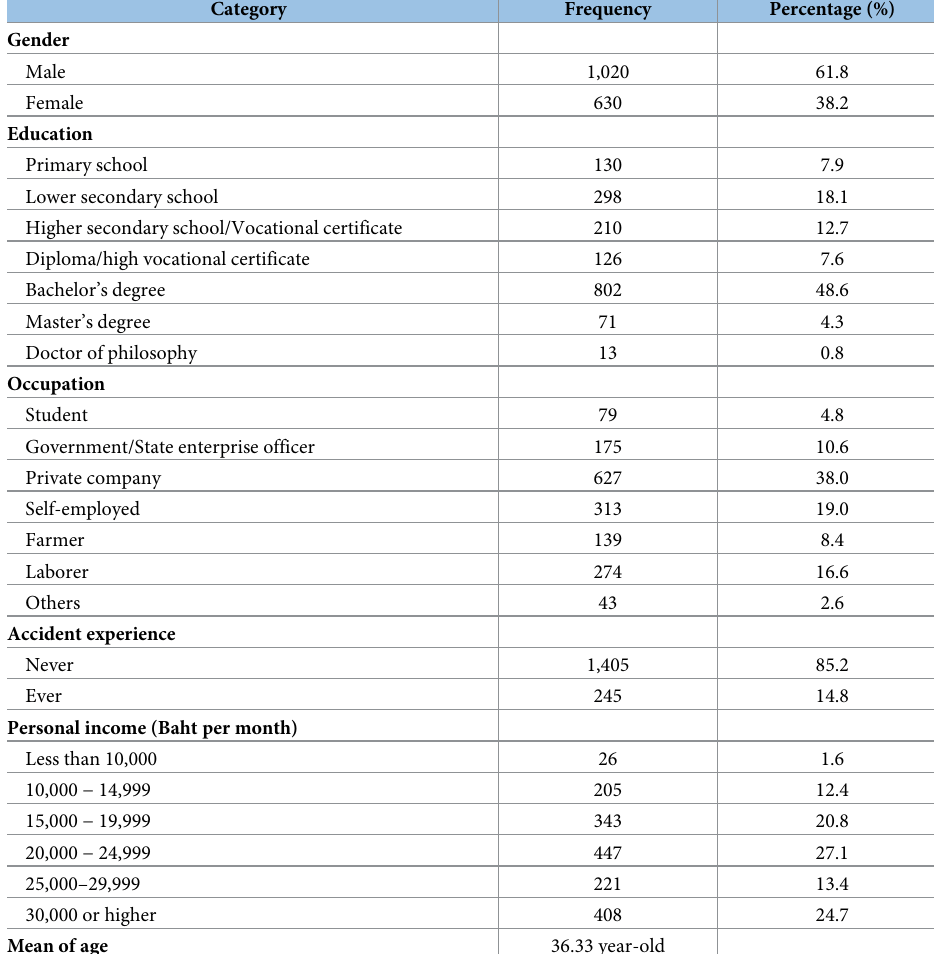
Table 2. Preliminary